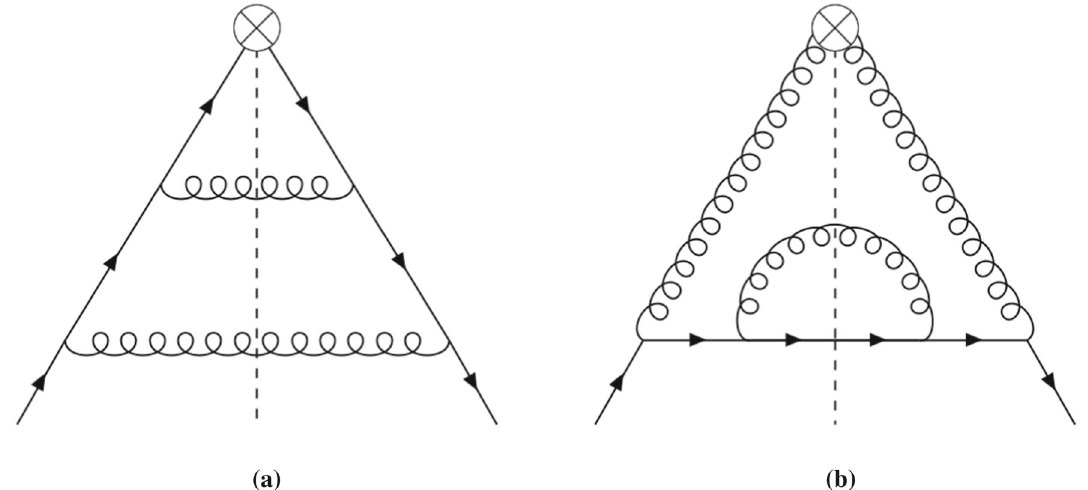
Fig. 1 Example diagrams contributing to the B qq ( a ) and B gq ( b ) beam functions. The dashed line represents a “cut” so that all particles crossing it are on the mass-shell. The vertex ⊗ denotes the insertion of the projection operator defined in Eq. (2.4)